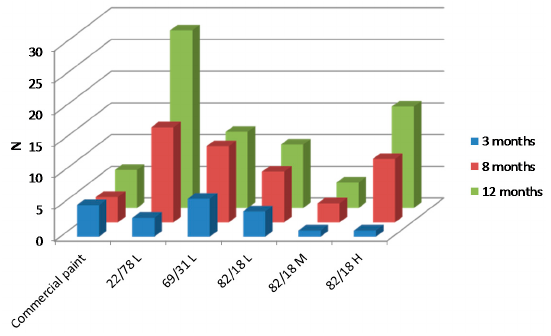
Figure 5. Values of the AF efficiency N for P(CL-VL) based paints immersed for 3, 8 and 12 months in Atlantic Ocean. Commercial paint was used as positive controls.